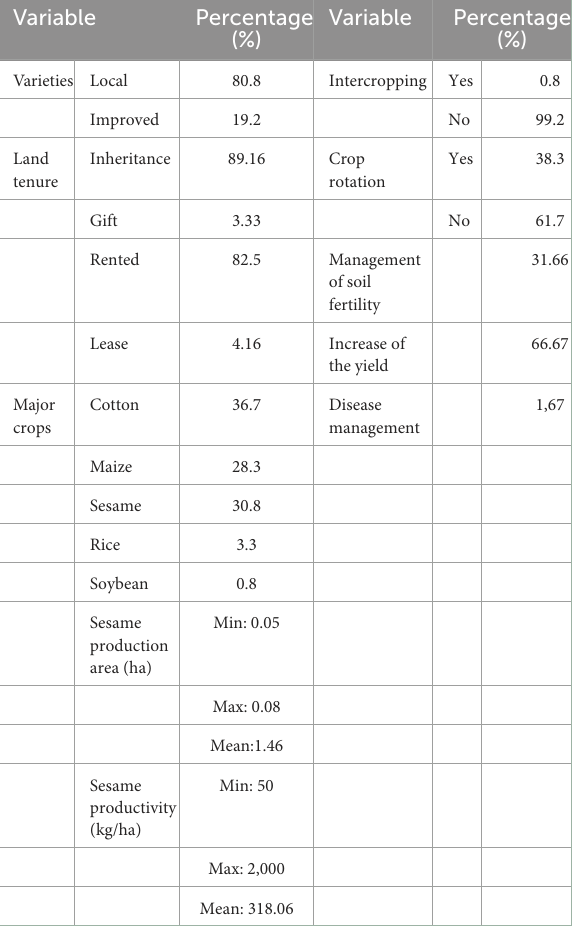
Varieties Local